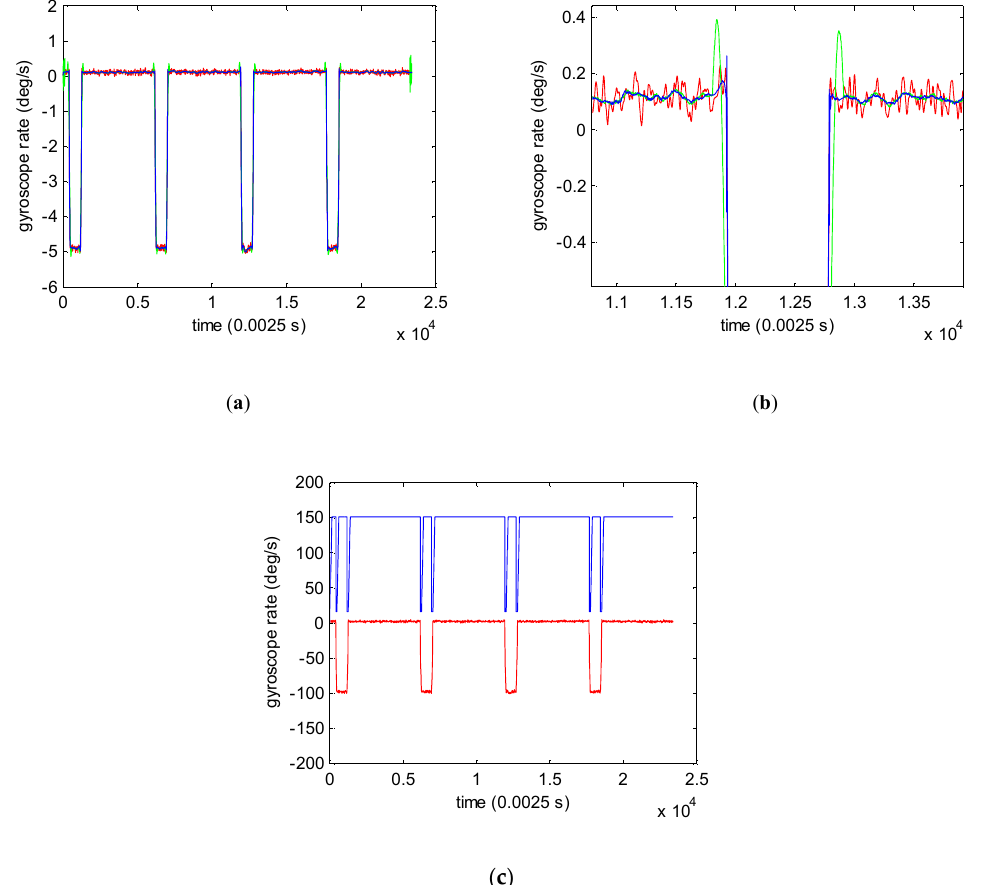
Figure 3. Denoising results of the adaptive multiscale SG filter (AMSGF) and fixed-window-size Savitzky–Golay (SG) filter. ( a ) Denoising results using AMSGF, W max = 151, W min = 15, λ th = 2.5 × 10 − 6 , M = 3. (Red: ACMP results of the original gyroscope signal; blue: further denoising results using AMSGF; green: further denoising results using the fixed window size SG filter with fixed window size of 151). ( b ) Local magnified image of denoising results in ( a ). ( c ) Window size selection of AMSGF at di ff erent samples (red: 500 times magnified ACMP results of the original gyroscope signal. blue: window size selection results at di ff erent